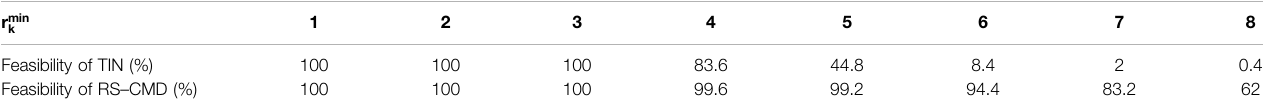
TABLE 2 | Percentage of feasible instances of the optimization problem (P 2 ) when deploying TIN and RS – CMD transmission strategies. Each BS is equipped with two antennas. r min k 1